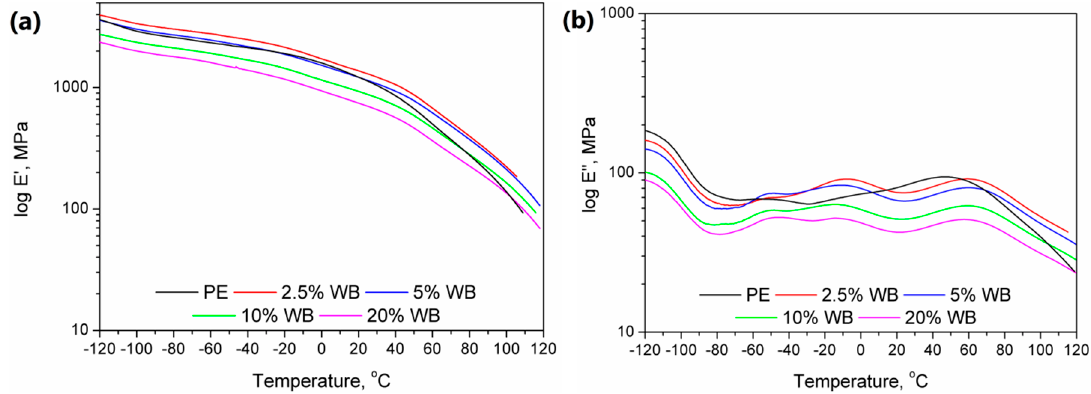
Figure 8. Temperature dependence of ( a ) storage (E’) and ( b ) loss (E”) modulus of prepared materials.